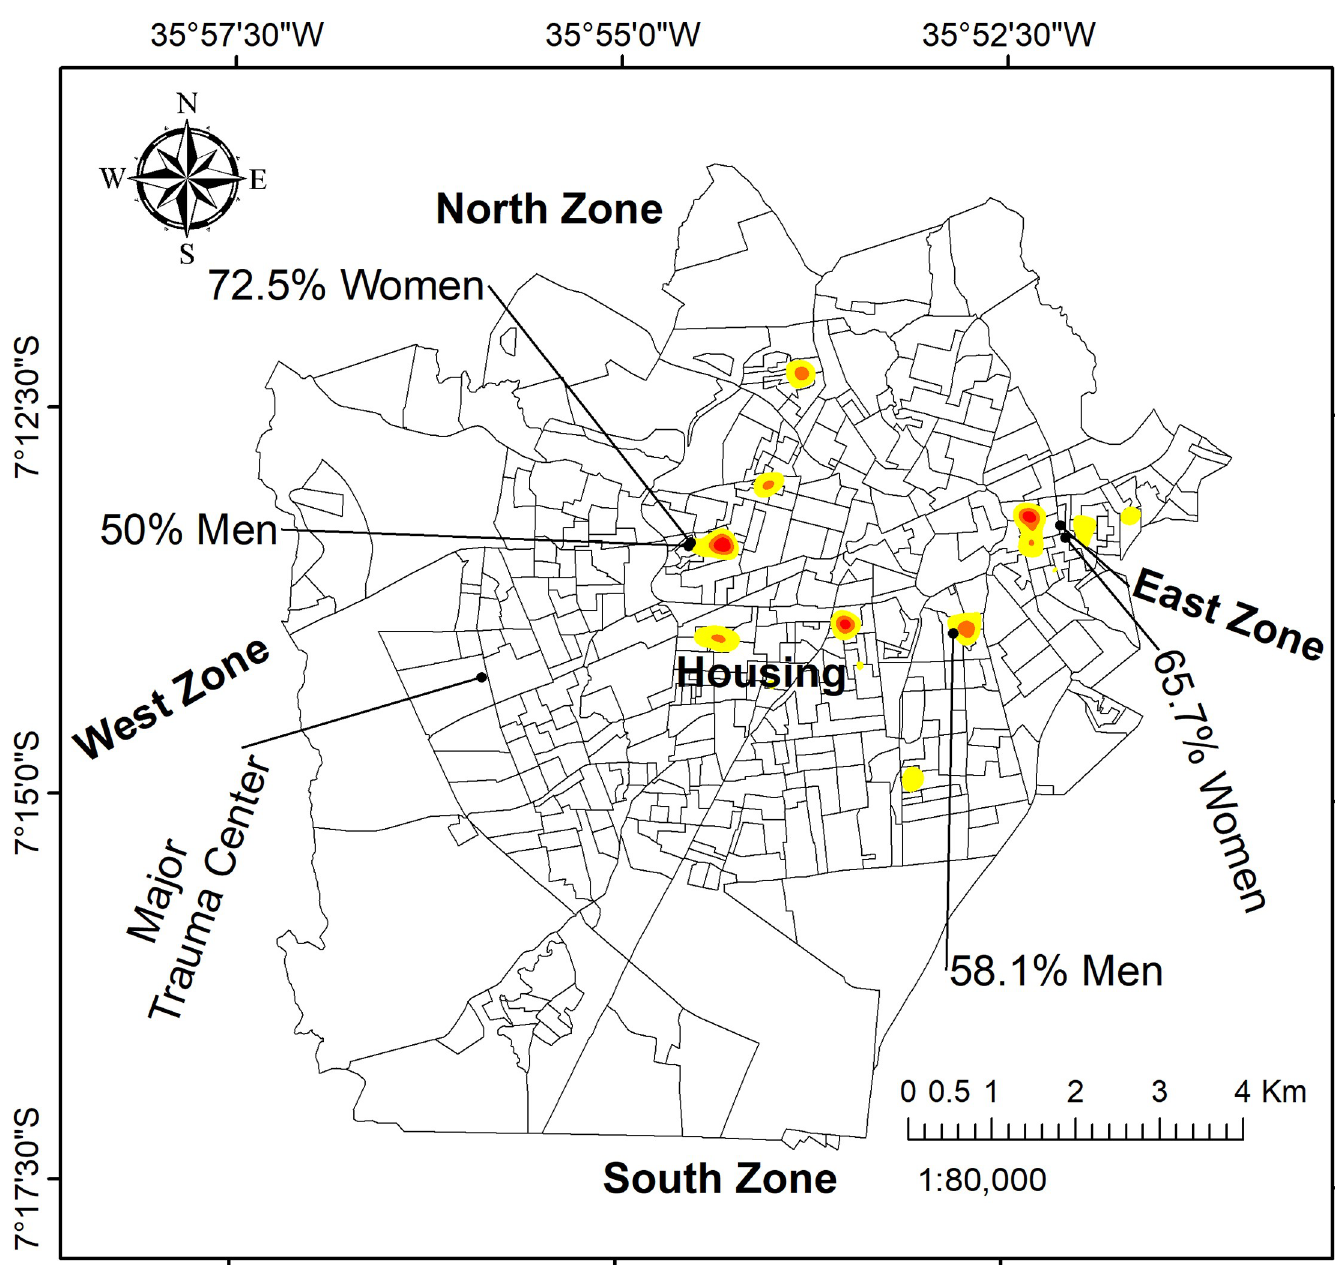
Fig 5. Density of community violence